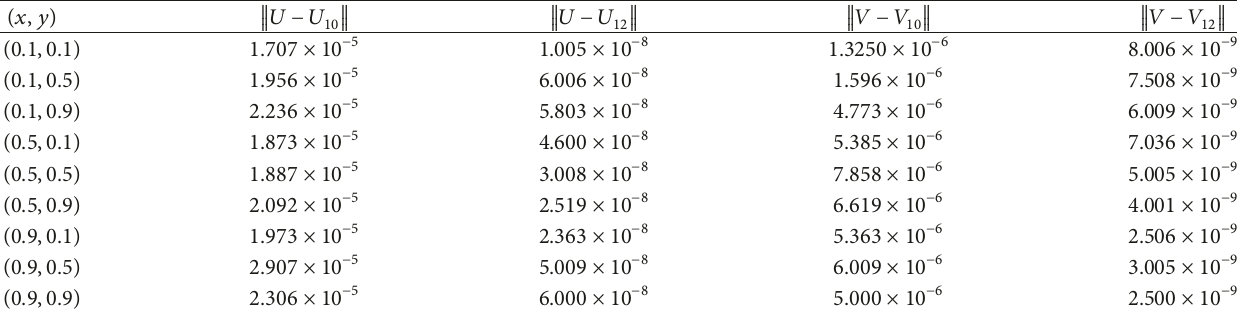
Table 1: Absolute error at various values of (𝑥,𝑦) for 𝐾 = 10, 12 in 𝑈(𝑥,𝑦) and 𝑉(𝑥, 𝑦) of Problem 1.